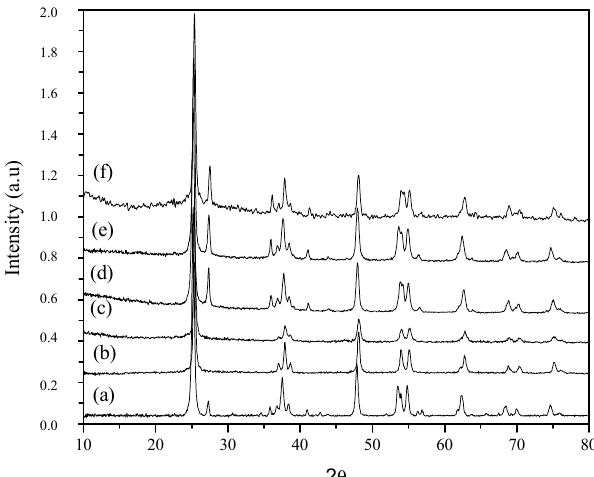
Figure 1. XRD patterns for photocatalysts analyzed. ( a ) TiO 2 ; ( b ) F-TiO 2 ; ( c ) Pt-F-TiO 2 ; ( d ) P25; ( e ) F-P25 and ( f ) Pt-F-P25.